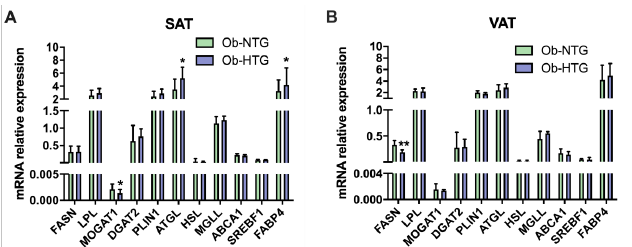
Figure 2. Expression analysis of genes implicated in lipid metabolism. ( A ) Gene expression levels in SAT. ( B ) Gene expression levels in VAT. Data are presented as the median (IQR). Ob-NTG, subjects with severe obesity and normotriglyceridemia; Ob-HTG, subjects with severe obesity and hypertriglyceridemia; SAT, subcutaneous adipose tissue; VAT, visceral adipose tissue. * = p < 0.05; ** = p <